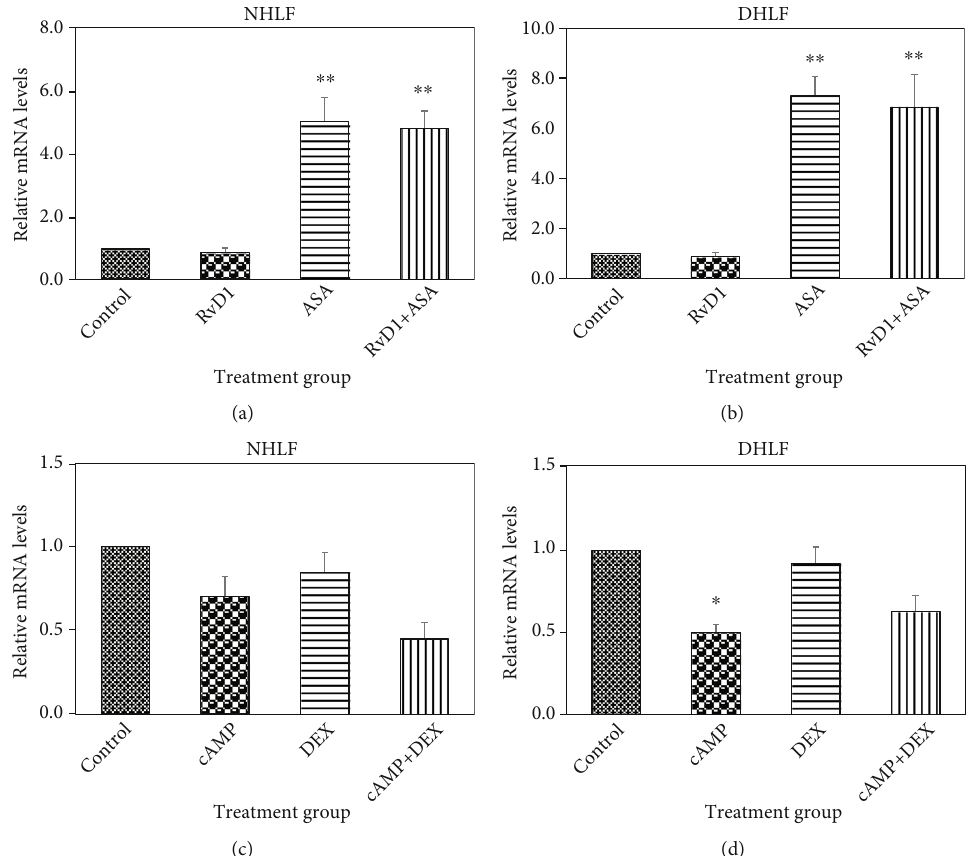
Figure 3: The e ff ects of RvD1, ASA, cAMP, and DEX on ARG2 mRNA levels in HLF. ARG2 mRNA levels were assessed in NHLF (a and c) and DHLF (b and d). HLF were treated with 1 μ M RvD1, 10 mM ASA, 100 μ M 8-Br-cAMP, or 2 μ g/mL DEX for 24 hours. RNA was then extracted from HLF and analyzed by RT-qPCR. Data were statistically analyzed using randomized block ANOVA, followed by Tukey ’ s multiple comparisons test. Depicted are the mean relative mRNA levels ± SEM for n = 3 biological replicates performed in triplicate for all experiments, except for the cAMP experiment in DHLF (d), for which n = 4 biological replicates were performed in triplicate. Stars indicate signi fi cant di ff erences determined using Tukey ’ s multiple comparisons test as follows: ∗ P < 0 : 05 and ∗∗ P < 0 : 01 signi fi cant di ff erence from